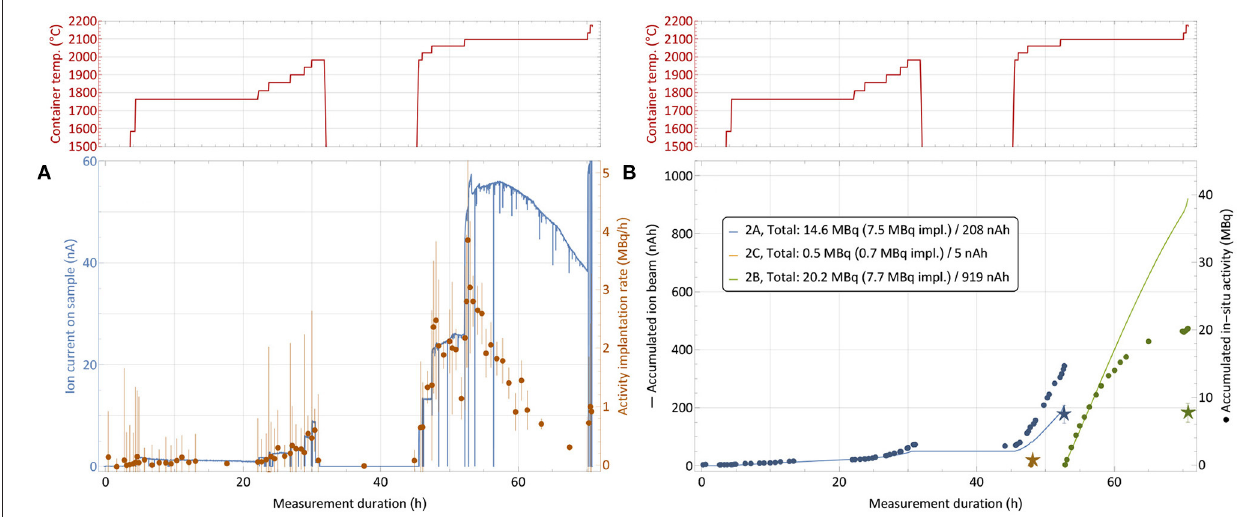
FIGURE 8 | 167 Tm collection process for sample 2 (76.9MBq 167 Tm, see Table 1 ) with distribution over multiple implantation foils. Depiction analogous to Figure 6 . The break between 32 and 45 h with cooled down container is due to a technical